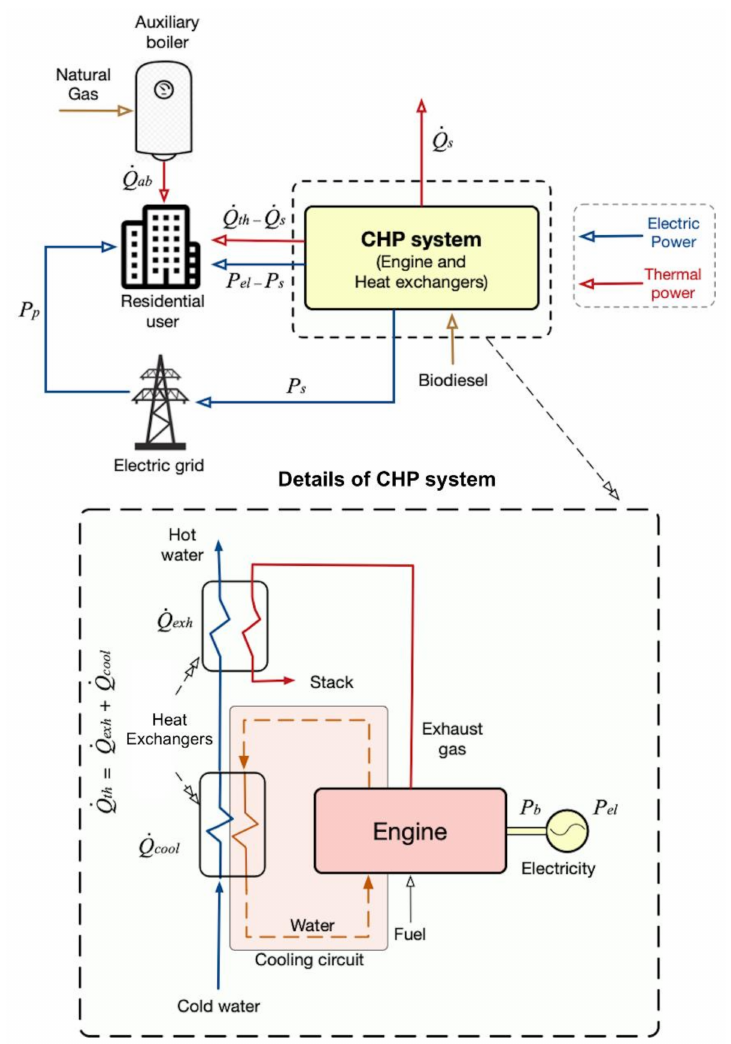
Figure 2. Micro-CHP system layout and energy